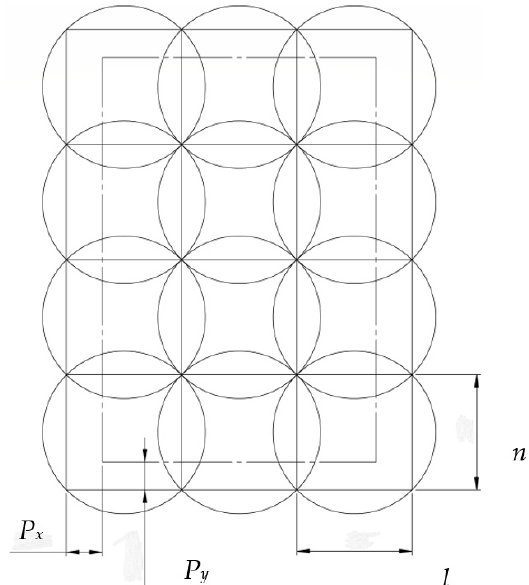
Figure 16. The schematic diagram of the filling model. The size of the rectangle inside the circle indicates the effective area size of the circle. The length and width of the maximum inscribed rectangle in the circle are both √2 r . The length and width of the inscribed rectangle of the circle are generally close to √2 r when the target rectangle is selected. The constraints of the filled model are shown in Equation (30).